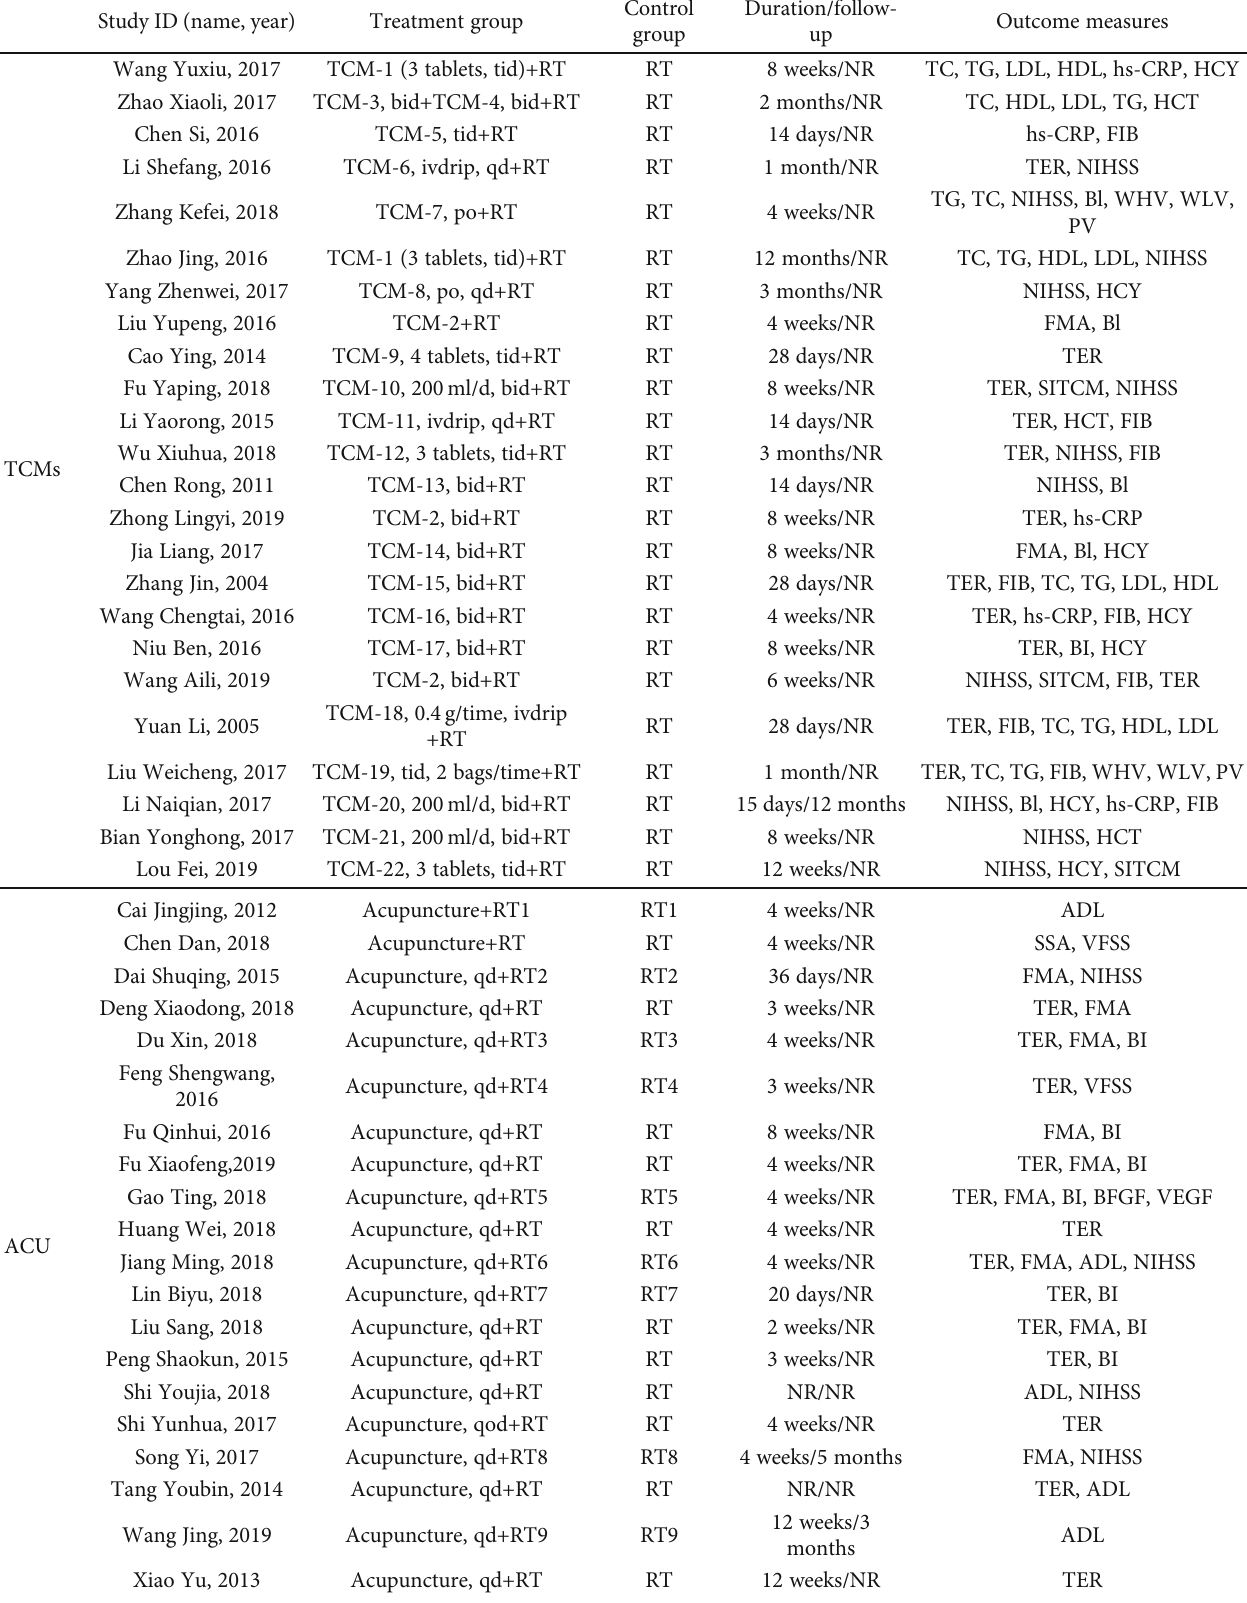
Table 2: Intervention characteristics of included